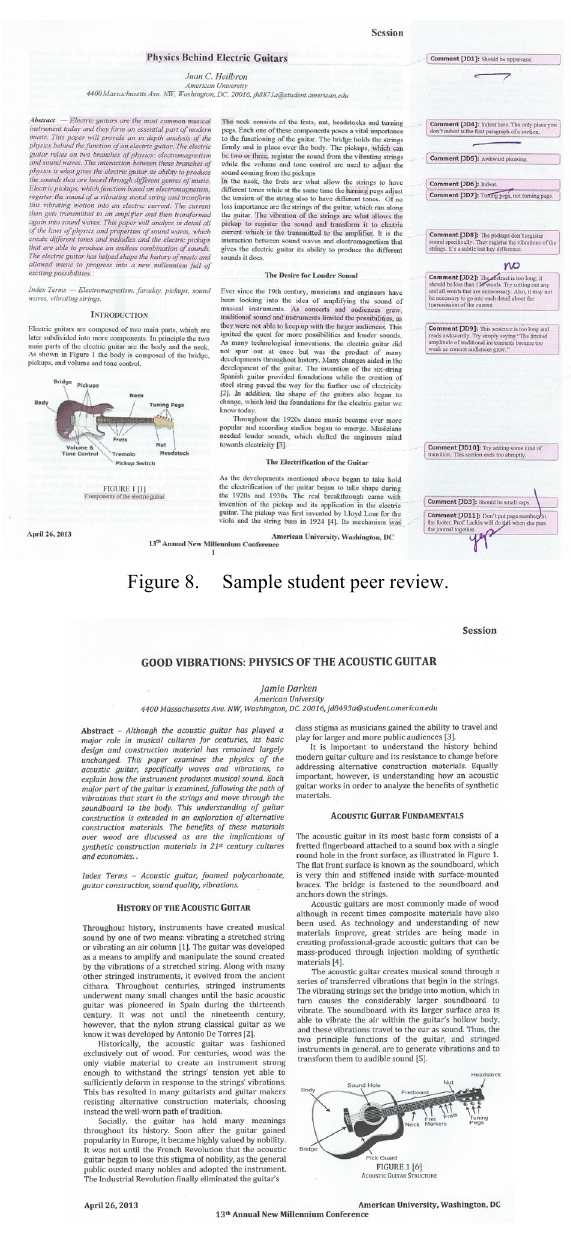
Figure 9. Final camera-ready